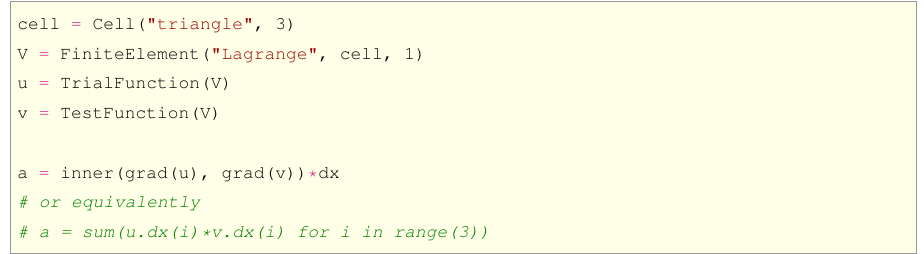
Fig. 4. UFL code defining the weak Laplacian operator from Eq. (22) for piecewise linear elements over a triangle embedded in R 3 . This code is included in the Supplement as snippets/laplacian.ufl.